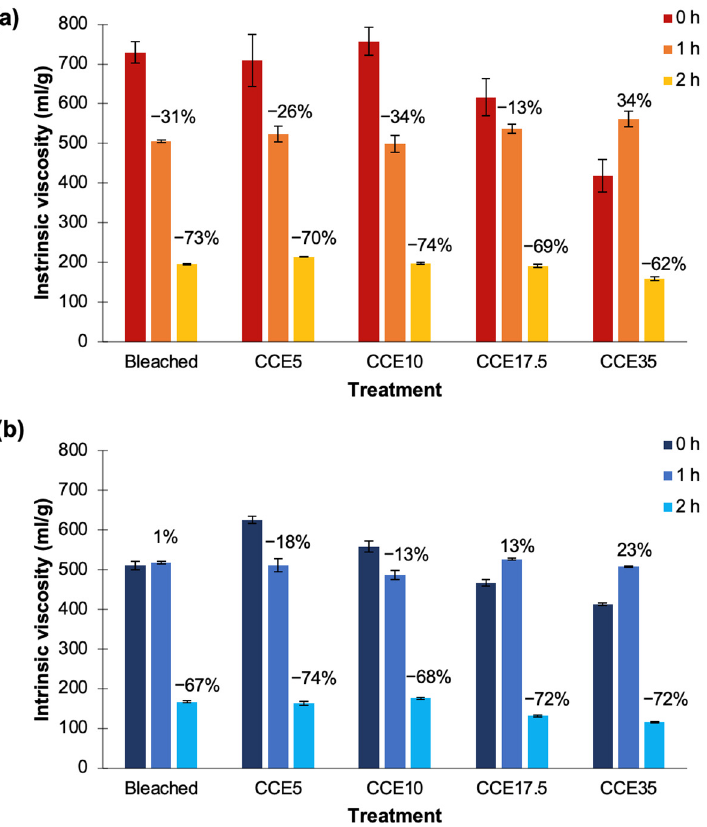
Figure 10. Variation of the intrinsic viscosity after EG treatments in ( a ) eucalyptus and ( b ) pine pulps. Dark blue: pulps without EG treatment. Light blue: EG treatment with enzyme load of 5 ECU/g pulp for 1 h. Gray: EG treatment with enzyme load of 10 ECU/g pulp for 2 h. Viscosity variations in pulps is dependent on the EG accessibility to cellulose chains.